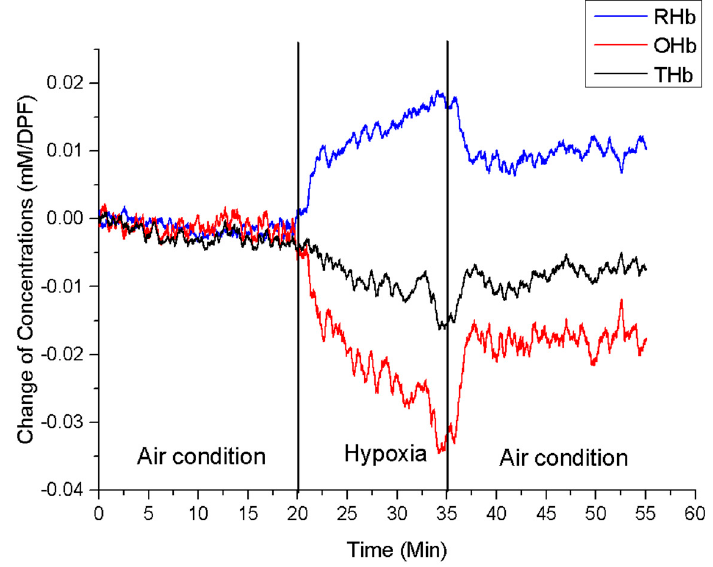
Figure 5. Representative result of the respiratory challenge test. (* RHb: deoxy-hemoglobin, OHb: oxy-hemoglobin, THb: total hemoglobin, mM: millimole, DPF: Di ff erential path length factor).